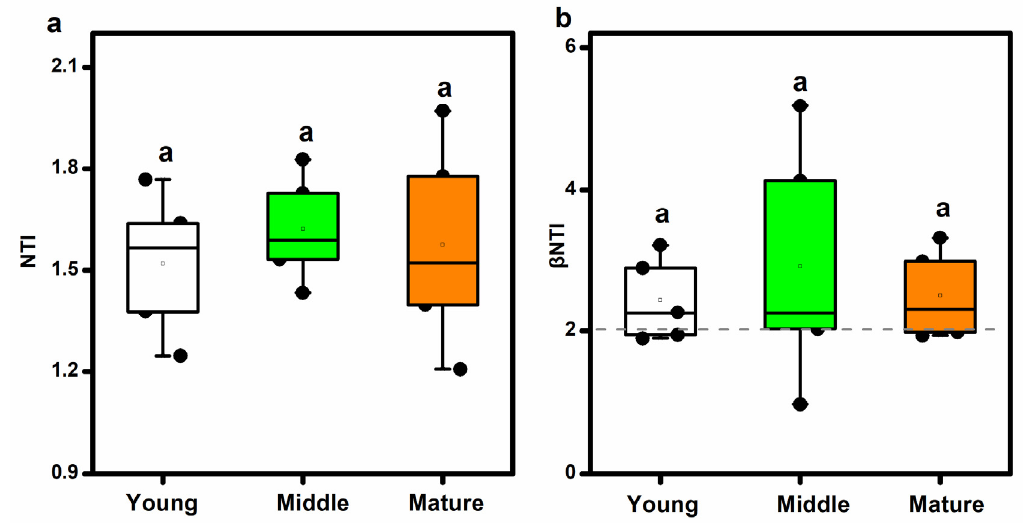
Figure 7. Soil AM fungal community assembly based on phylogenetic relatedness (nearest relative index, NRI) ( a ) and β NTI ( b ) during the development of C. lanceolata plantations. Bars topped by different letters indicate significant difference ( p <